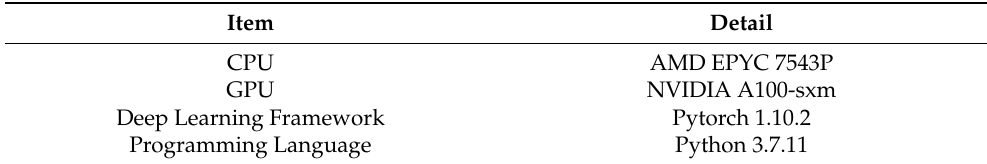
Table 5. Experimental environment configuration. Item Detail CPU AMD EPYC